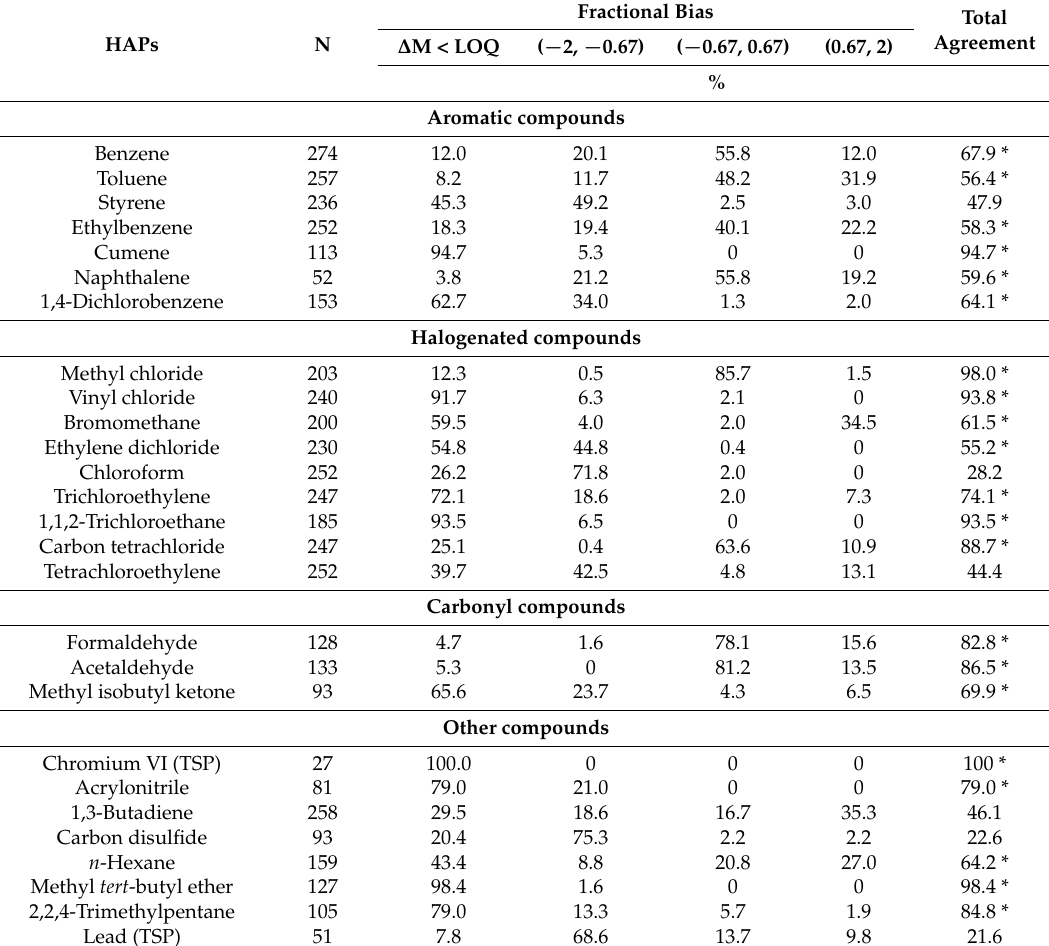
Table 4. Percentages of agreement, underestimation, and overestimation sites determined by NATA-AQS comparisons using the fractional bias